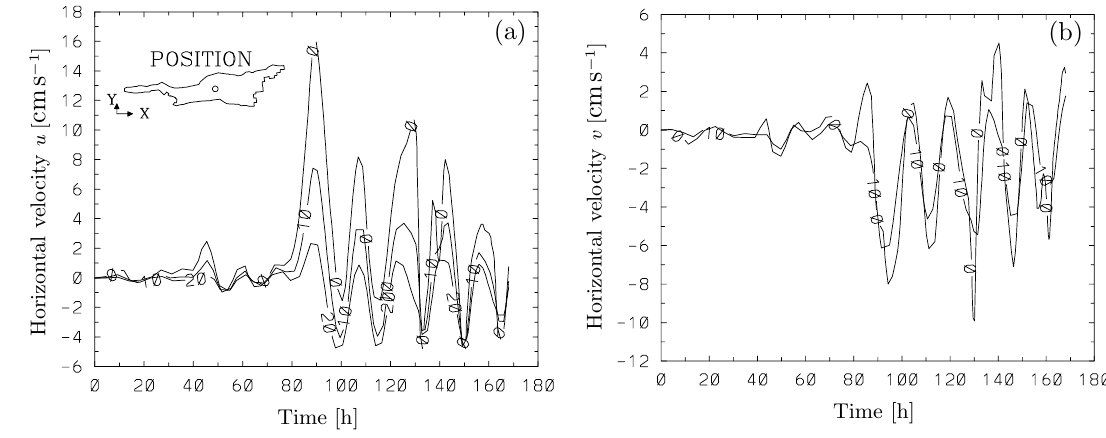
FIG. 24: Time series of the horizontal velocity components u (a) and v (b) at the center of the Obersee (see inset) subject to the wind forcing of Fig. 22. The labels indicate the depths in meters.